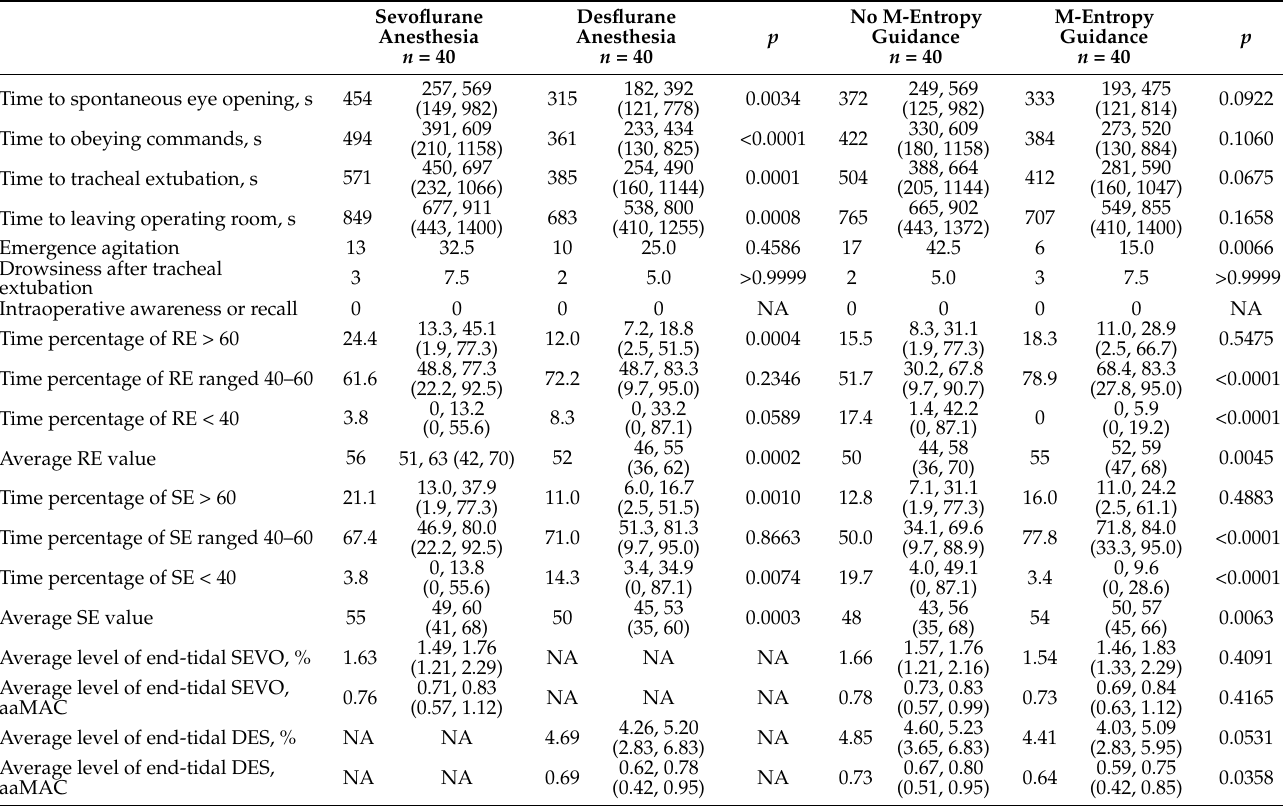
Table 3. Study outcomes of desflurane versus sevoflurane and M-Entropy guidance versus no guidance. Sevoflurane Anesthesia n = 40